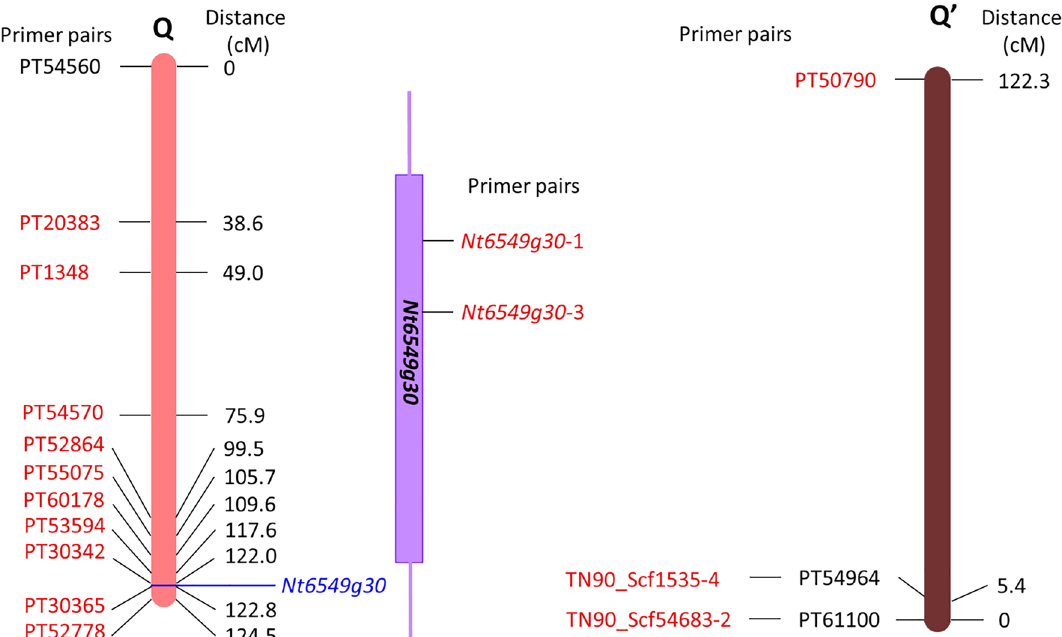
Figure 5. Locations of primer pairs on the Q chromosome (Linkage group No. 11), Nt6549g30 , and the Q ′ (Q homologous) chromosome (Linkage group No. 13). The primer pairs used in this study are indicated in red, whereas others are indicated in black. Nt6549g30 is closely linked to PT30342, as confirmed by linkage analysis 12 . Distance (cM) indicates genetic distance from the primer pair PT54560 on the Q chromosome, and from the primer pair PT61100 on the Q ′ chromosome. TN90_Scf1535-4 and TN90_Scf54683-2 are located